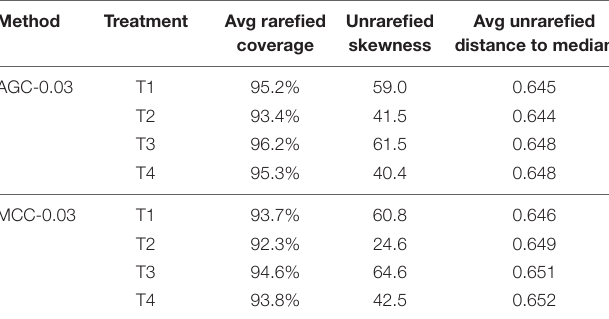
TABLE 5 | nrfA OTU table statistics for each agricultural treatment. Method Treatment